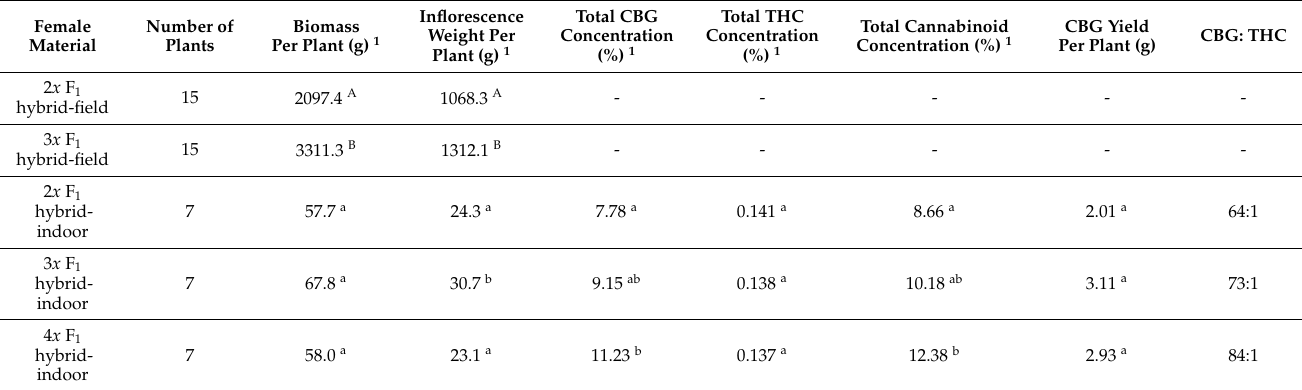
Table 3. Phenotypic traits of intra- and inter-ploid hybrids of C. sativa